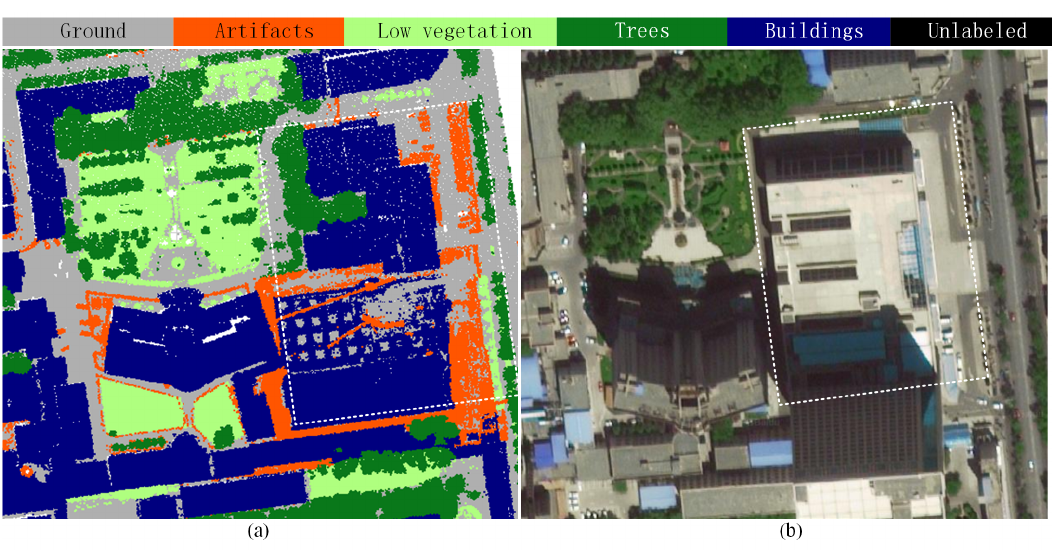
Figure 9. An example of the changed area in the test area. ( a ) ALS point cloud. ( b ) Satellite image of the same area. In the white dash line boxes, the changed area has been marked (from a construction site to a finished